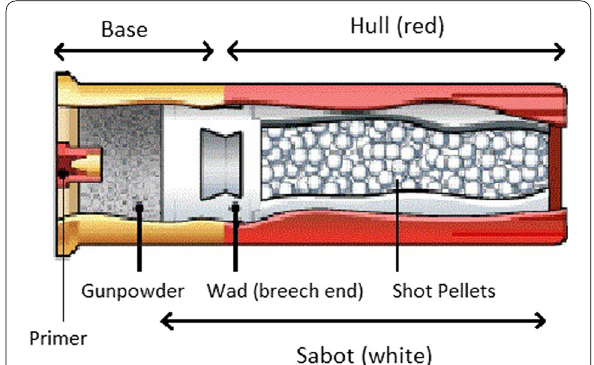
Fig. 1 A cut-away diagram demonstrating the components of a shotgun shell. A brass base (yellow) and hard plastic hull (red) compose the exterior. Inside the base are the primer and gunpowder. Inside the hull are the shot pellets, themselves contained in the sabot (white), the breech end of which is called a wad